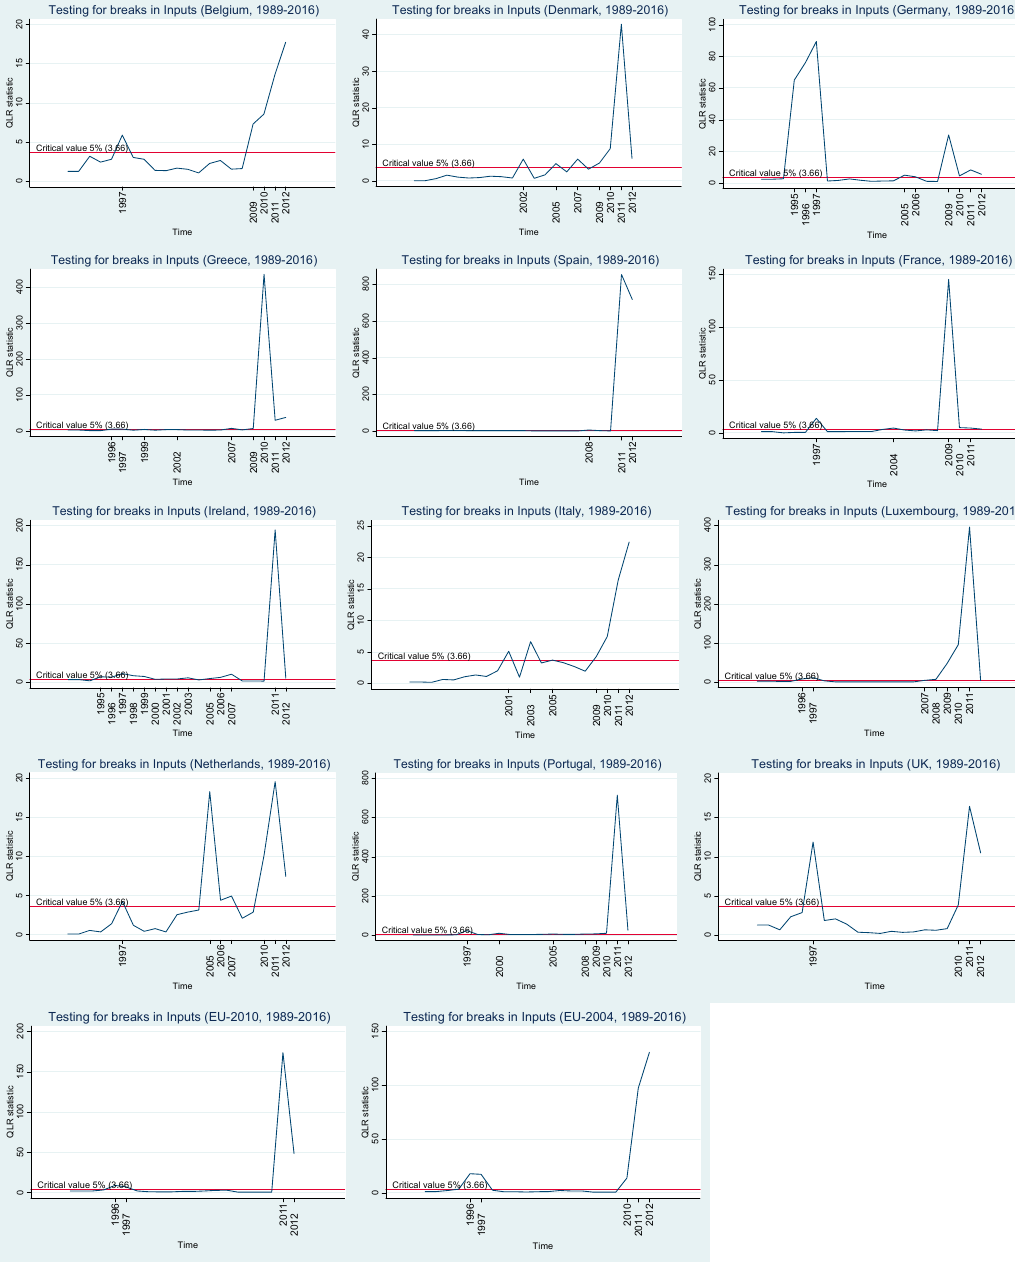
Figure 8. Testing for breaks in total inputs (euros) over the European Union countries (1989–2016).